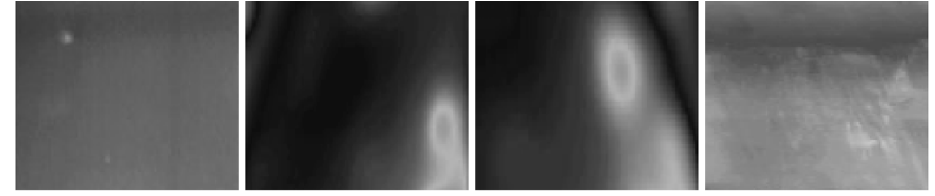
Figure 11. Augmentation techniques.